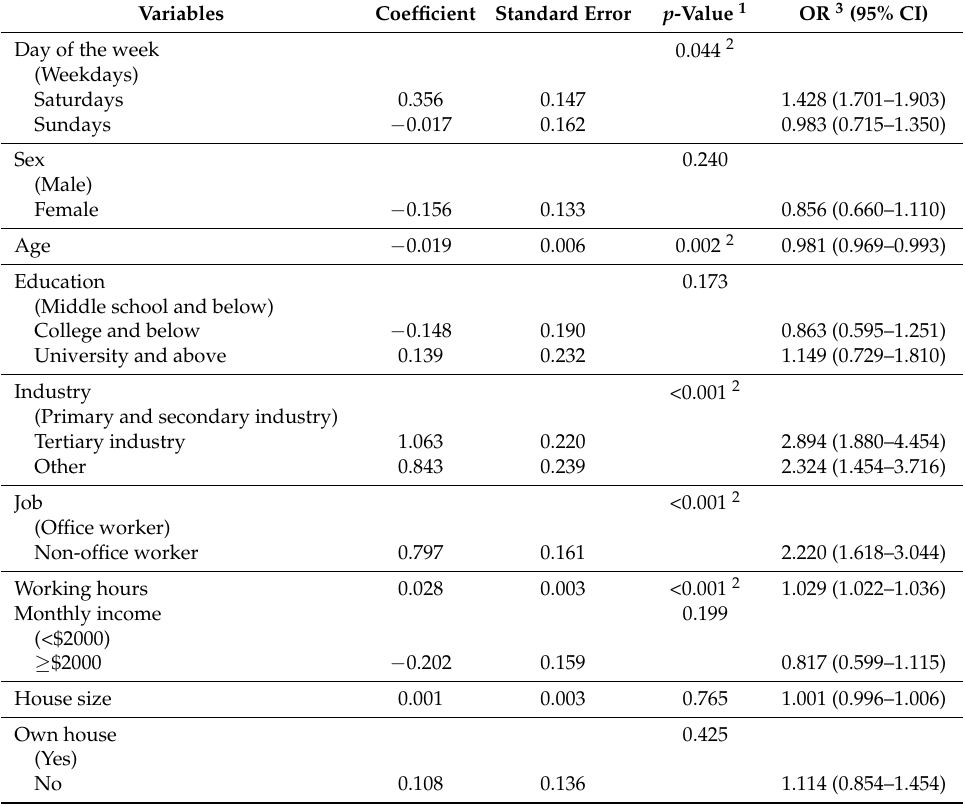
Table 2. Results of the multivariate logistic regression model of the high PM 2.5 exposure group.